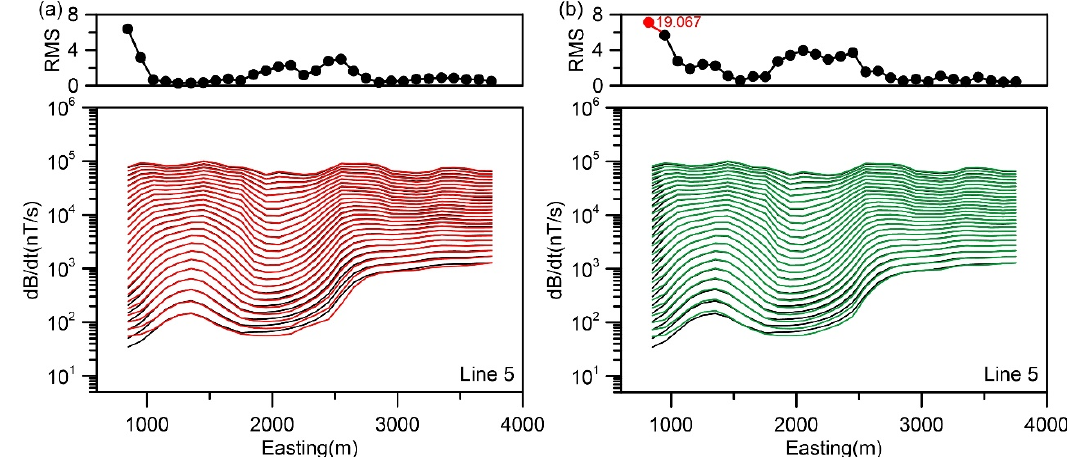
Figure 14. Data fitting and RMS for Line 5 in Figure 11. ( a ) Anisotropic inversion; ( b ) isotropic inversion. The black lines are for the inversion data, while the red and green lines are for predicted data.